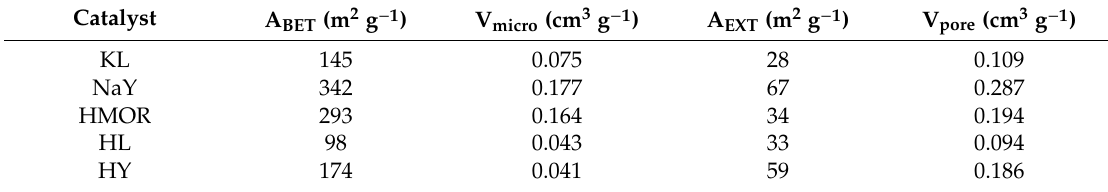
Table 1. Characteristic parameters of the porous texture of the catalysts.